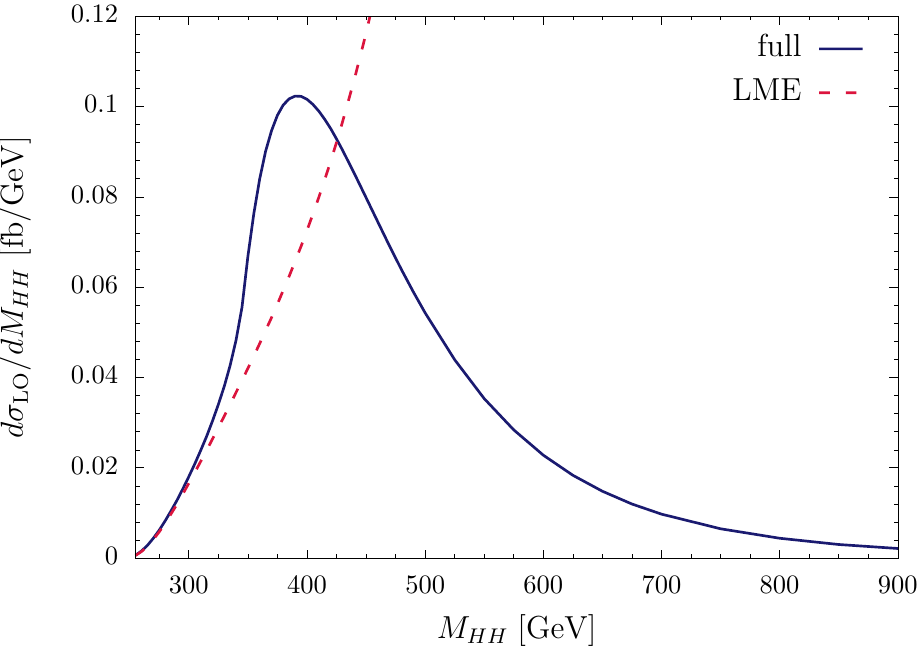
Figure 1 . Invariant Higgs mass distribution for the full LO cross section (dark blue) and the large mass expansion (LME) up to O (1 =m 8 ) as given in ref. [24] t